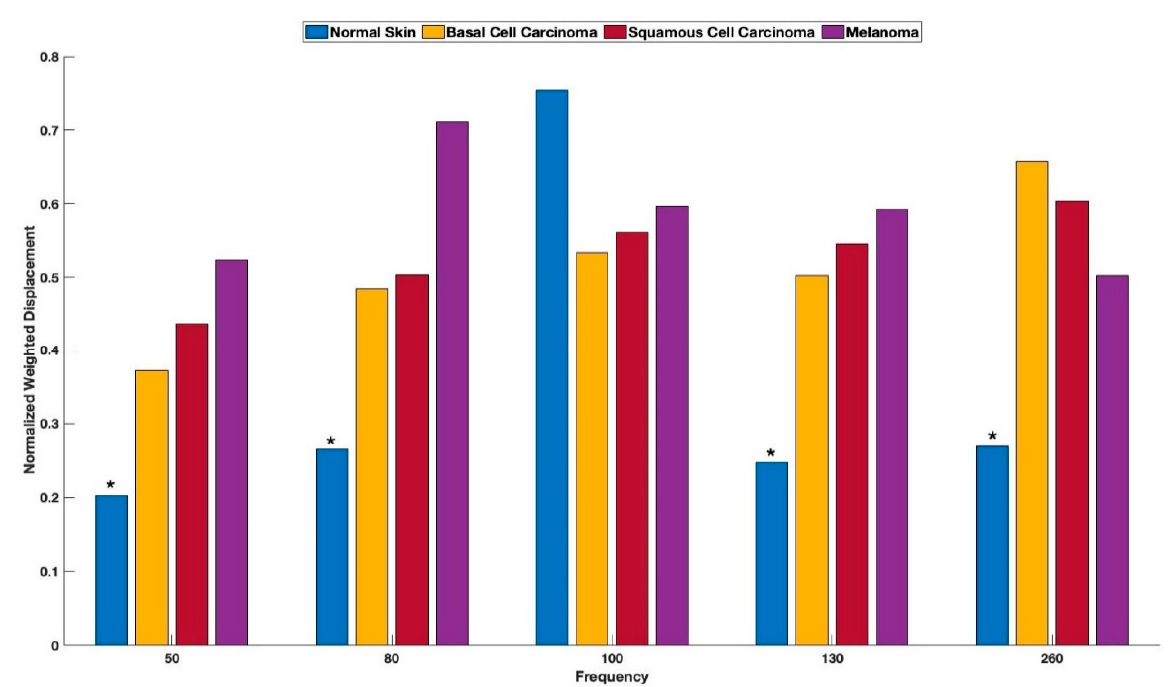
Figure 5. Normalize average peak heights for normal skin, BCC, SCC, and melanoma. Note: the asterisks denote statistical difference at a 0.95 level using a paired two tailed student’s t test of normal skin and all the cancerous lesions.